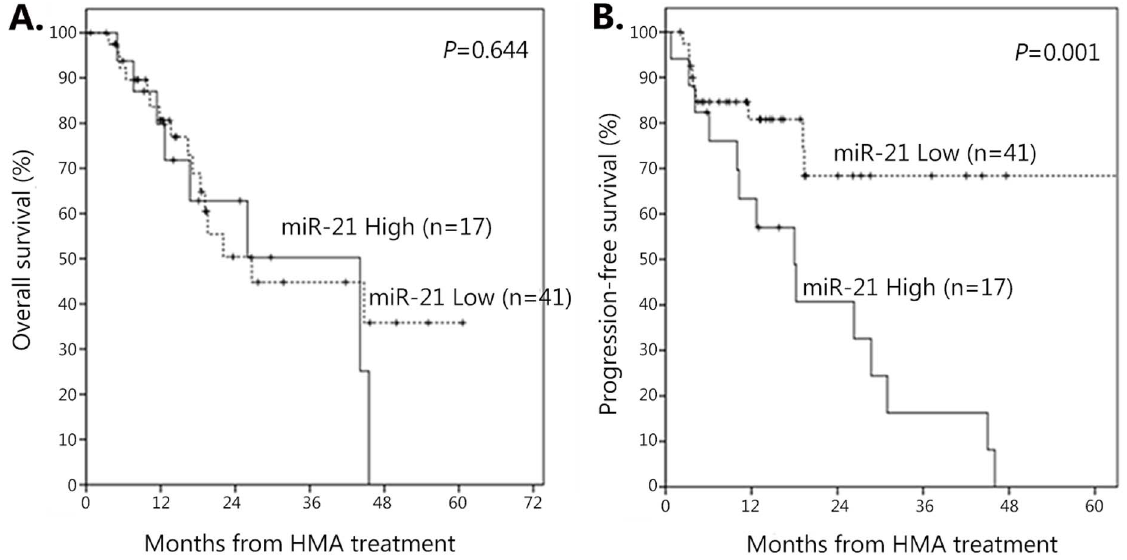
Figure 2. Differences in baseline serum miR-21 expression levels. (A) Difference in serum miR-21 levels between healthy donors and patients with MDS prior to HMA therapy. Expression levels of serum miR-21 were normalized to the reference gene, miR-192, which was selected as described in Design and Methods. (B) Difference in baseline serum miR-21 levels between responders to HMA therapy and non-responders. Bar graph and whisker indicate the median value and standard deviation of serum miR-21 levels, respectively. Significance is indicated by the P value.